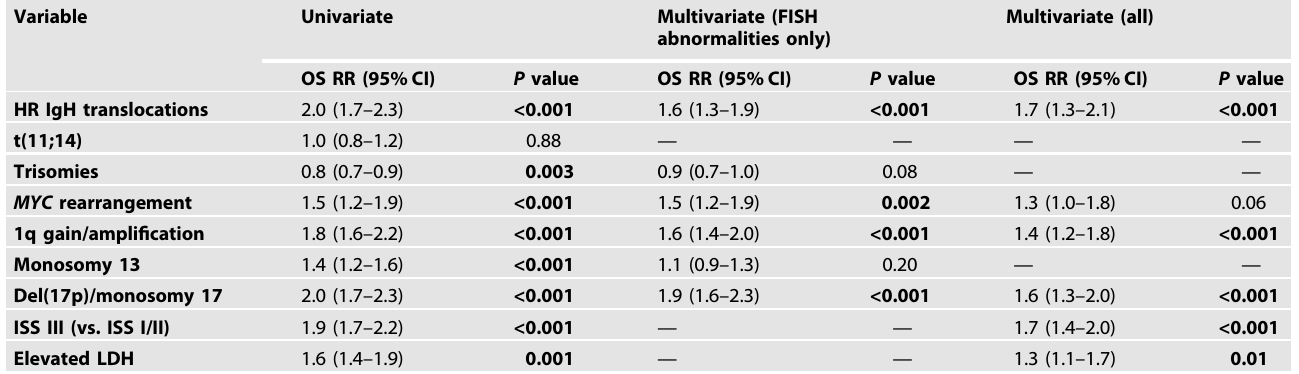
Table 3. Univariate and multivariate survival models.